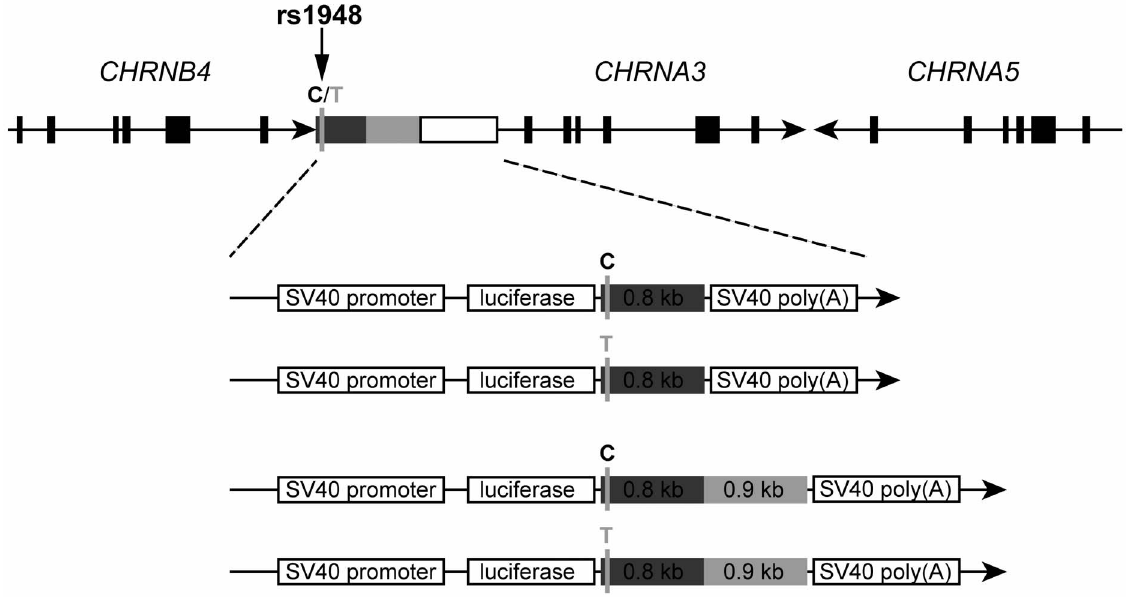
Figure 1. Schematic representation of the CHRNA5/A3/B4 cluster of genes. Schematic representation is shown according to the UCSC Genome Browser Human Feb. 2009 (GRCh37/hg19) Assembly. Arrows indicate direction of transcription. SNP rs1948 is indicated by a vertical arrow in the 3 9 -UTR of CHRNB4. Black boxes on the arrow line represent exons. Different shade of gray in the a 3/ b 4 intergenic region indicates fragments used to design the constructs. The four types of constructs are shown below the cluster, each with the major (black) and minor/risk (grey) allele listed.